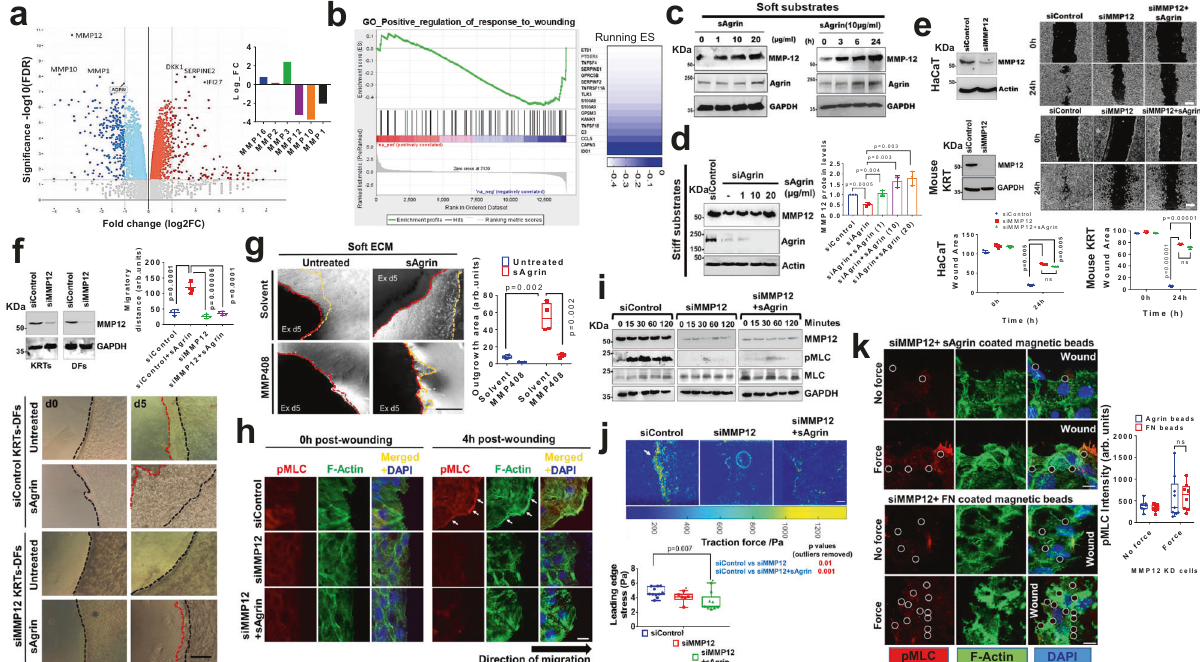
Fig. 5 MMP12 potentiates Agrin ’ s mechanoperception. a Volcano plot of differentially expressed genes in si-control and si-Agrin HaCaTs. Inset showing MMP genes. ( n = 3 replicates). b GSEA showing the downregulated gene cluster. c Western blot for the indicated proteins from HaCaT cells on 0.8 KPa under varied sAgrin concentrations for 18 h (left) or 10 μ g/ml sAgrin for the varying time (right). d Western blot for the indicated proteins in control, Agrin depleted and rescued HaCaT on 30 KPa. MMP12 bands were quanti fi ed as mean + / − s.d. ( n = 3, Two-stage, Holm − Sidak Multiple t-tests). e Western blot detecting MMP12 levels in indicated cells. Bright- fi eld microscopy images of same cells post-scratch assay. Wound area presented as mean + / − s.d. ( n = 3, two-tailed Students ‘ t ’ tests, ** p = 0.005, *** p = 0.0001, respectively). Scale: 50 μ m. f Western blot showing MMP12 knockdown ( n = 2). Bright- fi eld images of control and si-MMP12 cells migrating with/without 10 μ g/ml sAgrin on 0.8KPa. Scale: 100 μ m. Black and red dotted lines show the initial wound and end-migrated areas. Migration area was quanti fi ed as mean + / − s.d. ( n = 4 wounds, two-stage Benjamini Multiple ‘ t ’ tests, *** p = 0.0001 and **** p = 0.00006). g Mouse skin explants on 0.8 KPa with/without 20 μ g/ml sAgrin were treated with DMSO or MMP408 (5 nM). Bright- fi eld images showing outgrowth on day 5. Scale: 50 μ m. Outgrowth area was quanti fi ed ( n = 4 per group, Two-tailed Students ‘ t ’ test, ** p = 0.002, Box-1-99 percentile, whiskers-minimum to maximal values, central line-median). h Confocal images showing p-MLC, F-Actin, and DAPI staining in control or MMP12 silenced HaCaTs in the presence or absence of sAgrin. Scale: 10 μ m. White arrows show actomyosin cables. i Cell lysates from HEK treated as in ( h ) were analyzed by Western blot ( n = 3 repeats). j traction force map in control and si-MMP12 HaCaTs with/without sAgrin (10 μ g/ml) for 18 h. Scale: 100 μ m. Mean traction stress (in Pascals) are shown ( n = 6 images from three experiments, two-tailed Students ’ t ’ test, * p = 0.007, Box- 1-99 percentile values, whiskers- minimum to maximum, central line-median). k Confocal images showing pMLC-F-Actin and DAPI staining upon sAgrin/Fibronectin-induced force in MMP12-depleted HaCaTs. Scale: 10 μ m. White circles represent beads. Mean pMLC intensity + / − s.d. was quanti fi ed from three experiments ( n = 10 cells per group, two-tailed Students ‘ t ’ test, ns, Box-1-99 percentile, whiskers- minimum to maximum values, central